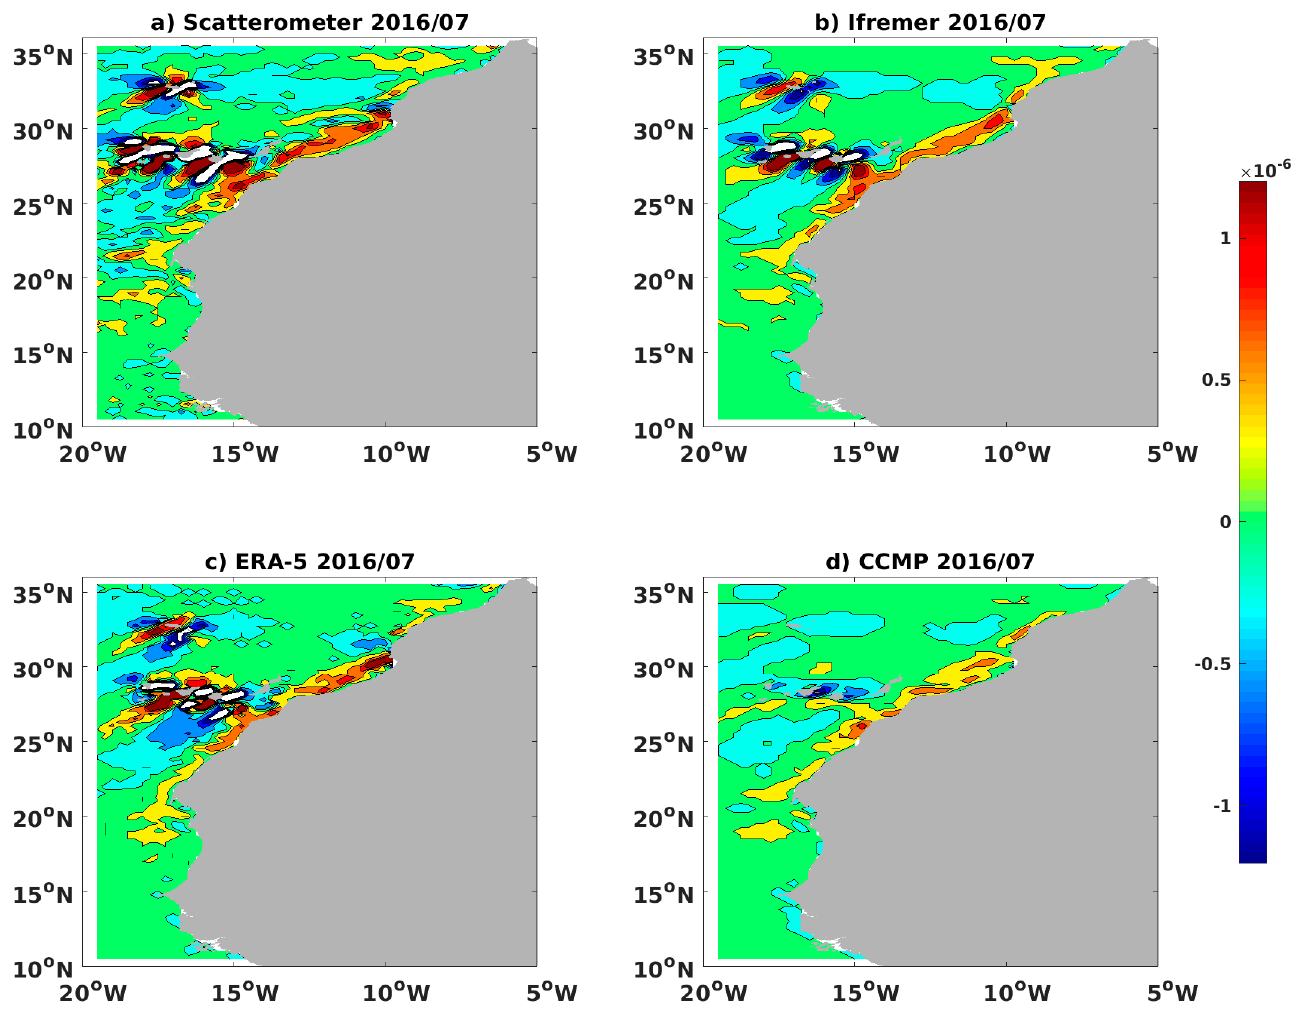
Figure A8. Monthly-averaged mean of wind stress curl estimated from collocated ( a ) scatterometer (ASCAT), ( b ) Ifremer, ( c ) ERA-5, and ( d ) CCMP wind data occurring in July 2016 over the Canary zone. Colors indicate curl amplitudes in N/m 3 . White and black colors indicate curl values lower than − 1.210 − 6 N/m 3 and higher than 1.210 − 6 N/m 3 , respectively.